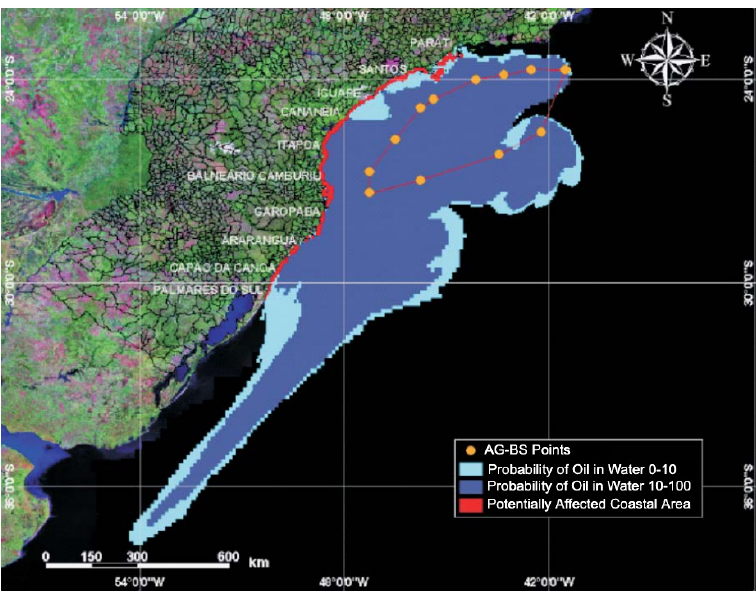
Figure 2. Probability of oil in the water and potentially affected coastal area.